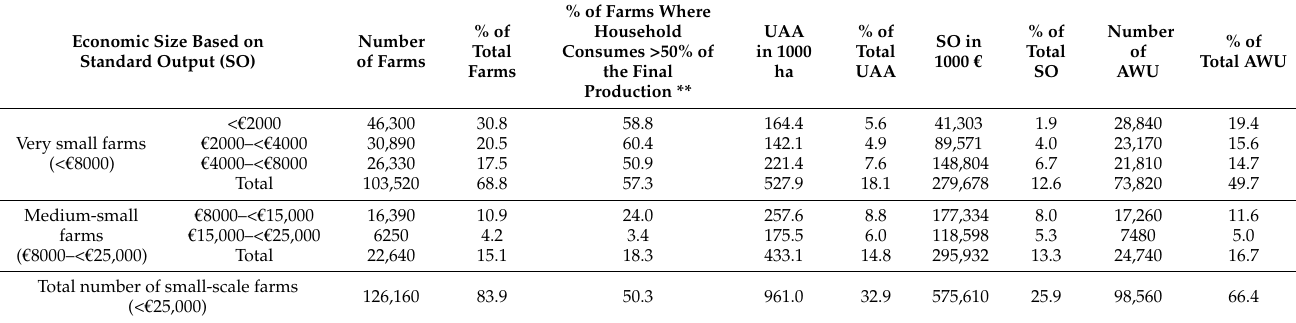
Table 2. The main statistical characteristics of economically small-scale farms * in Lithuania,